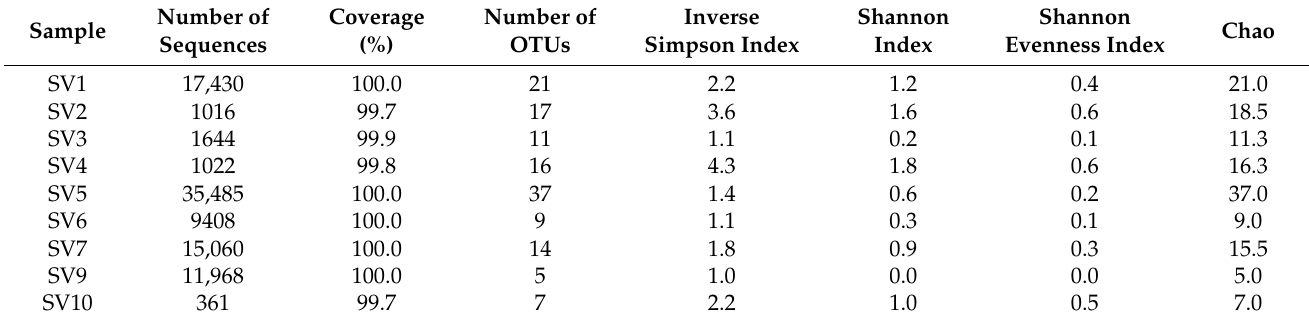
Table 3. Illumina sequencing statistical results and diversity indexes for domain Archaea .